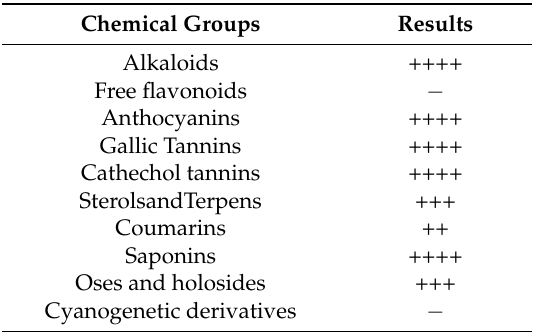
Table 2. Phytochemical screening results of the leaf powder of Salvia argentea